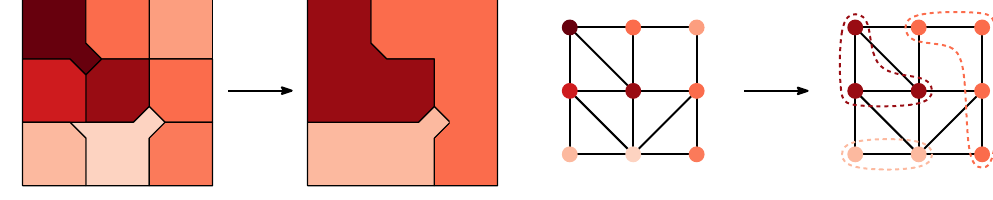
Figure 1: An example of area aggregation (see Haunert and Wolff